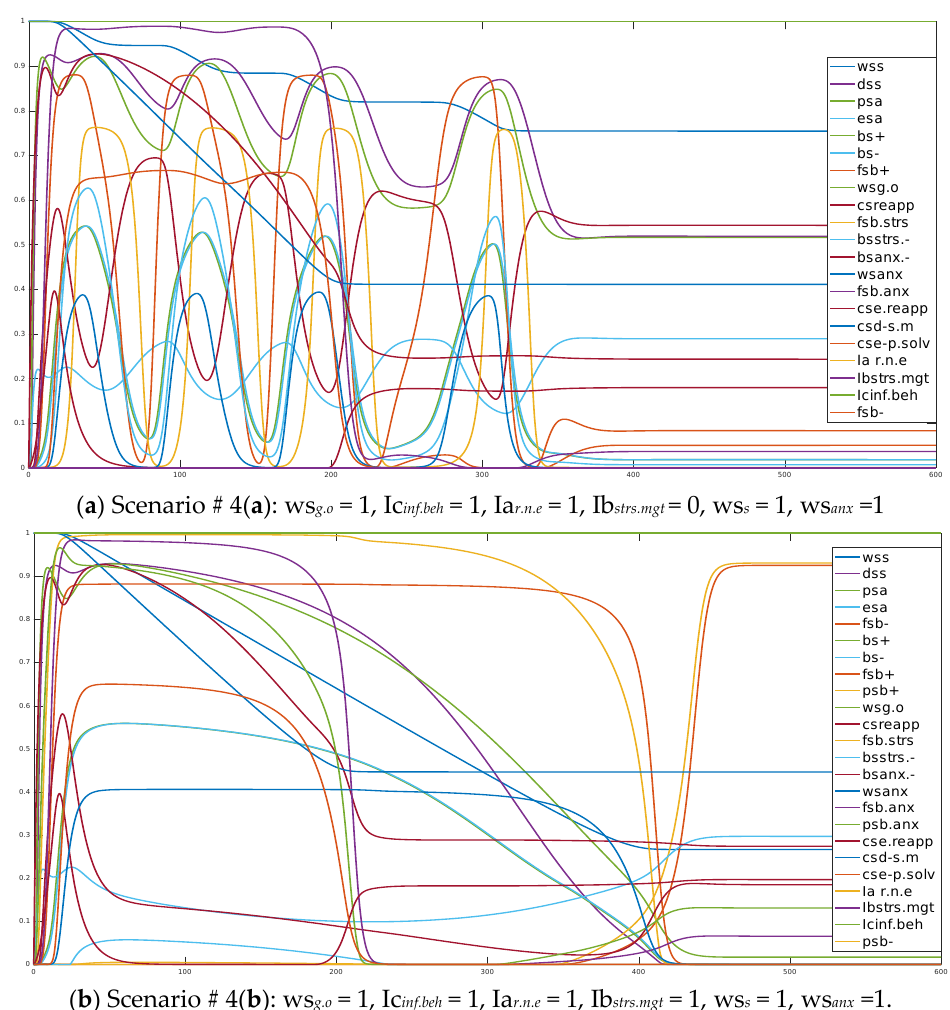
Figure 5. ( a ) Lack of stress management but eventually stable. ( b ) Avoiding anxiety-induced overeating through multiple interventions